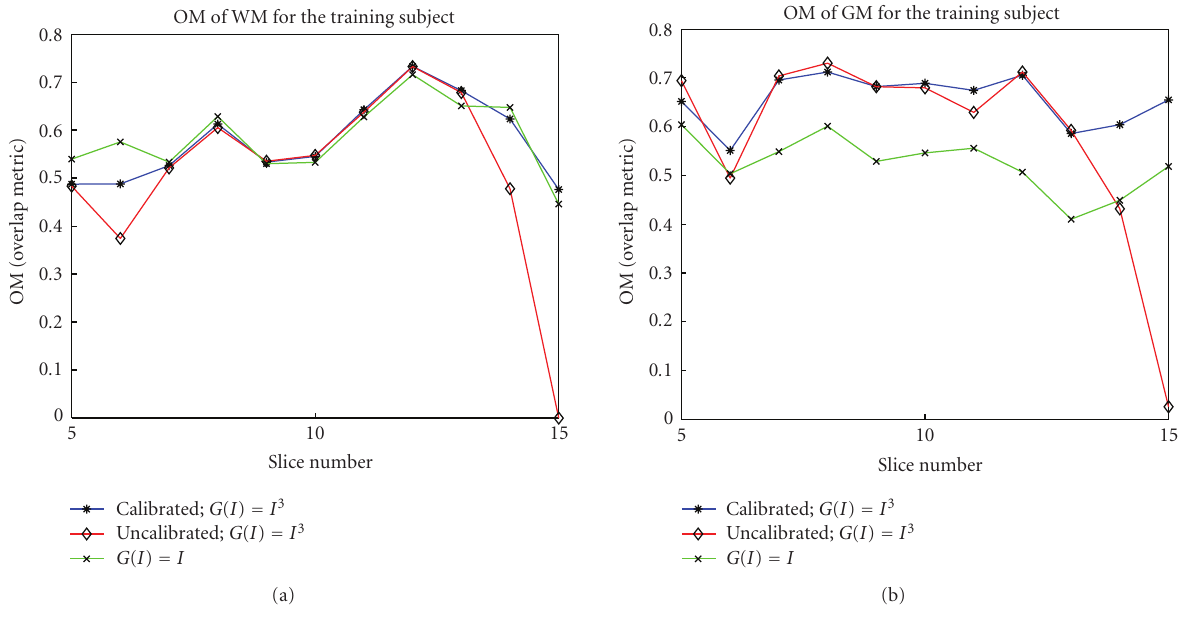
Figure 12: Overlap metric of (a) WM and (b) GM segmentations for calibrated and uncalibrated T 1 -Maps with cubic function G ( I ) = I 3 and tuned weights and also for calibrated T 1 -Map with function G ( I ) = I with tuned weights.